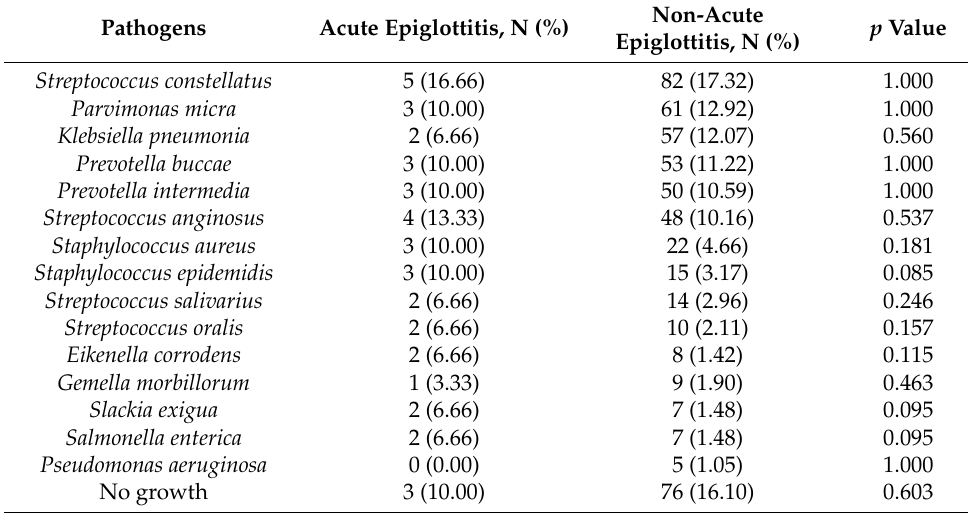
Table 3. Comparison of pathogens between 30 patients with concurrent acute epiglottitis and deep neck infection and 472 patients with deep neck infection